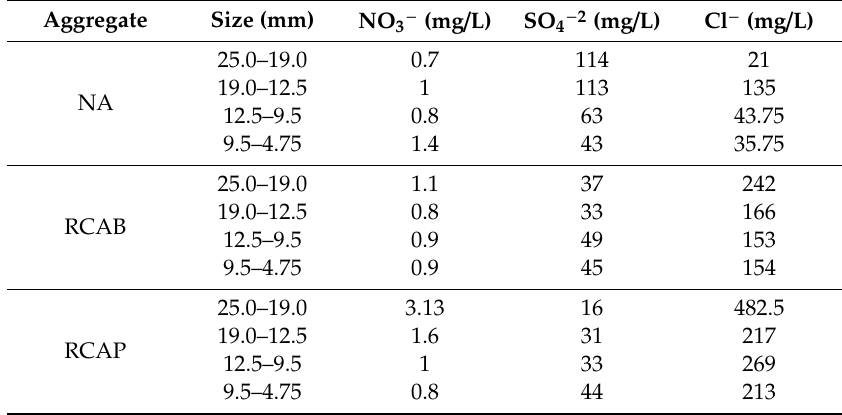
Table 7. Results of the physicochemical analysis (UV spectrophotometer).